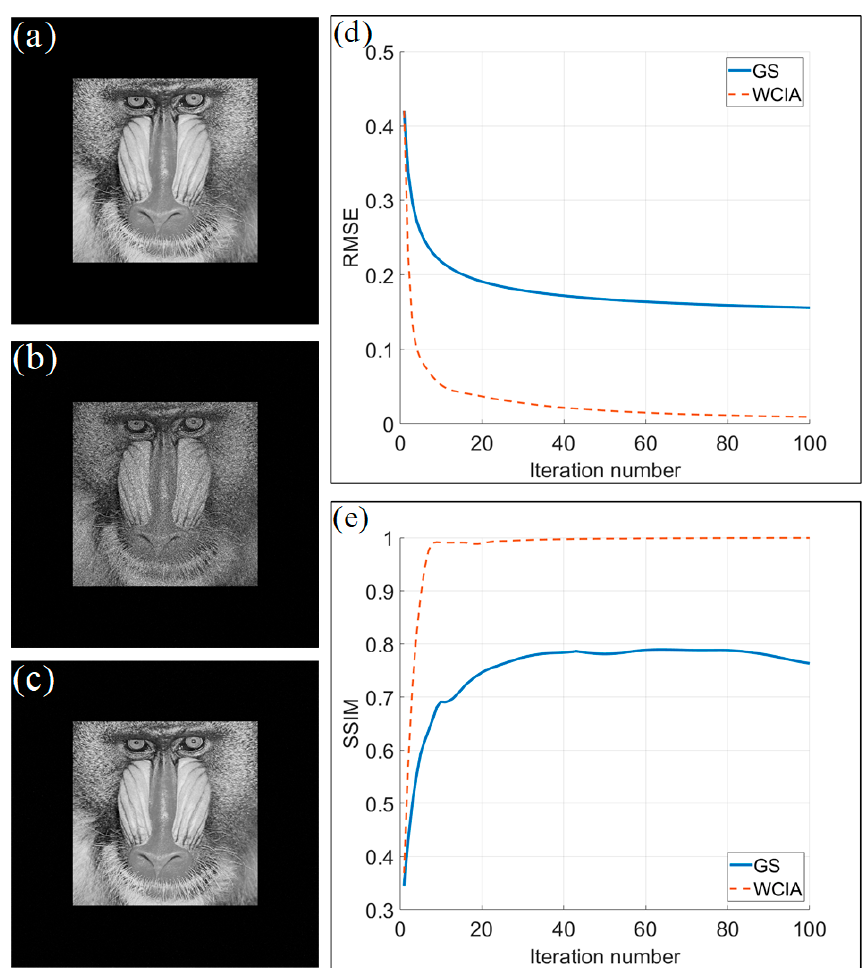
Figure 4. Numerical simulations: ( a ) target image; reconstructed images with ( b ) Gerchberg–Saxton (GS) algorithm and ( c ) WCIA; ( d ) comparison of the root-mean-square errors (RMSE); ( e ) comparison of the structural similarity index measures (SSIM).